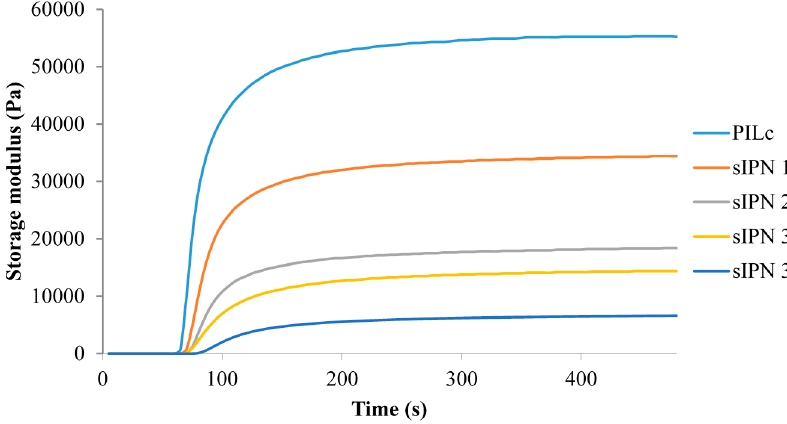
Figure 5. DSC curve excerpt showing the LCST transition of a 2.5% w/w p(NiPAAm ‐ BSP ‐ AA) linear copolymer solution. The full DSC curve follows a heating program from 14 °C to 70 °C at a heating rate of 10 °C/min.